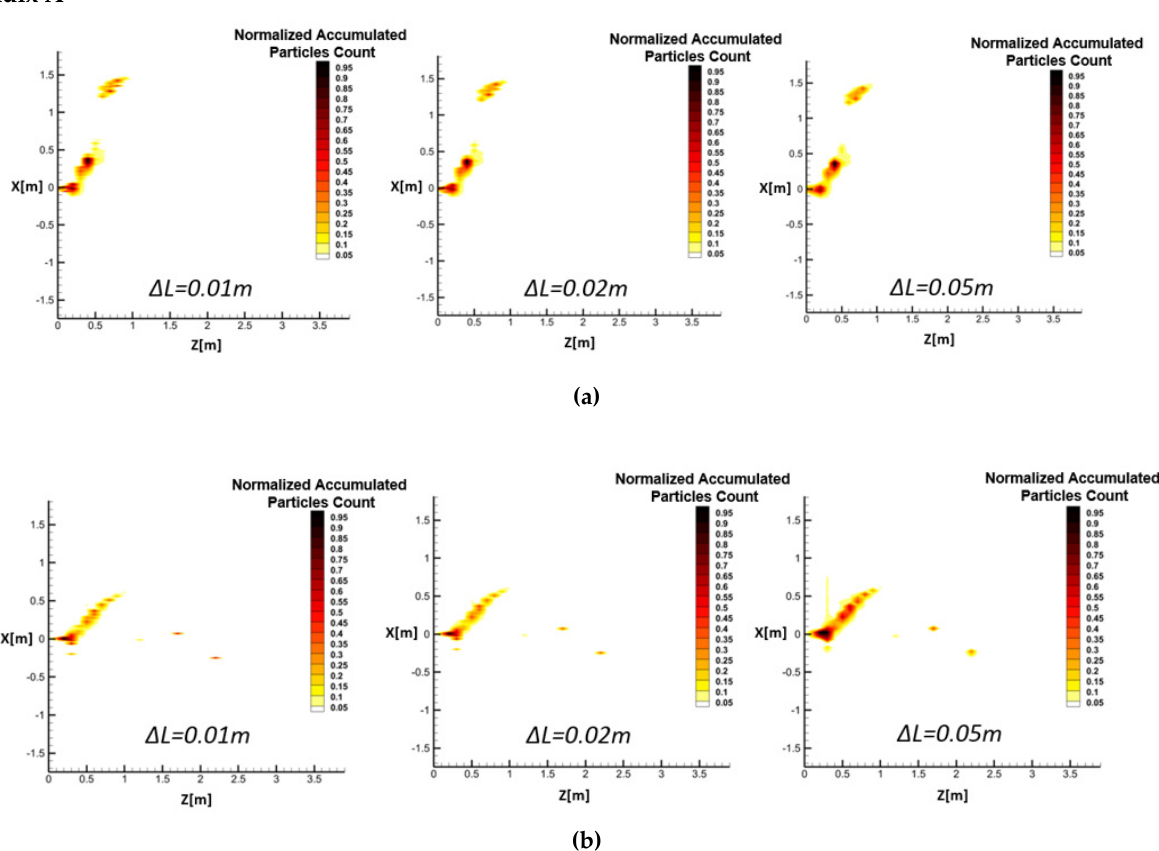
Figure A1. The impact of ∆ L size on the accumulated number of droplets in ( a ) a cough respiratory event (velocity = 8 m.s − 1 , temperature = 15 °C, RH = 50%), and ( b ) in a sneeze respiratory event (velocity = 50 m.s − 1 , temperature = 29 °C, RH = 50%).